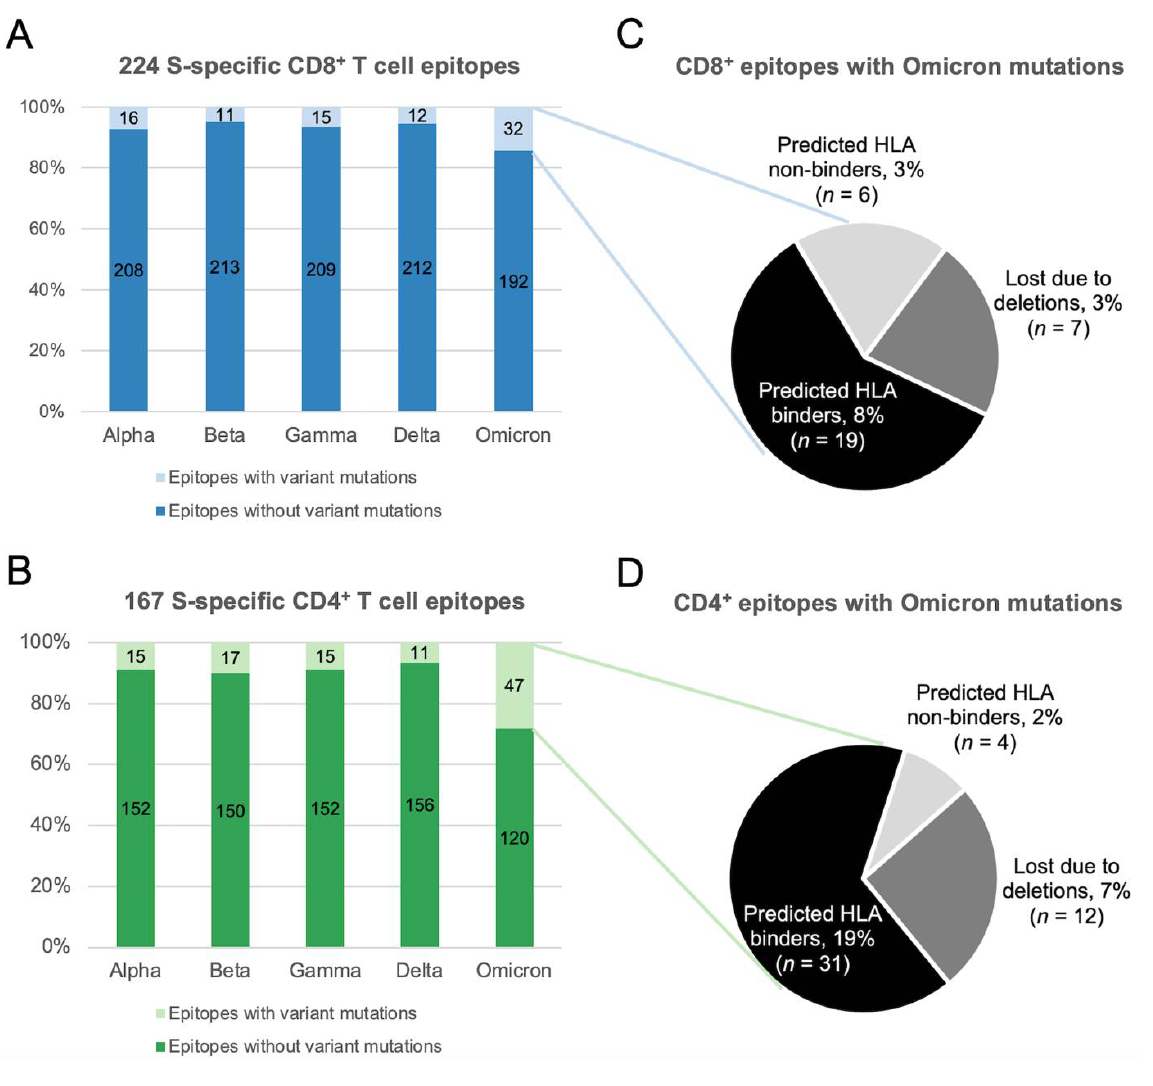
Figure 1. Percentage of S-specific SARS-CoV-2 T cell epitopes with and without mutations present in the five VOCs: ( A ) CD8 + T cell epitopes. ( B) CD4 + T cell epitopes. Only epitopes of canonical lengths (CD8 + : 8–12 residues and CD4 + :15 residues) were included in the analysis. VOC-defining mutations (that also include deletions) were obtained from https://covariants.org (accessed on 9 December 2021). Predicted effect of Omicron mutations on peptide-HLA binding of SARS-CoV-2 ( C ) CD8 + and ( D ) CD4 + T cell epitopes. NetMHCpan-4.1 and NetMHCpanII-4.0 were employed for predicting peptide-HLA binding using the default parameters [13].